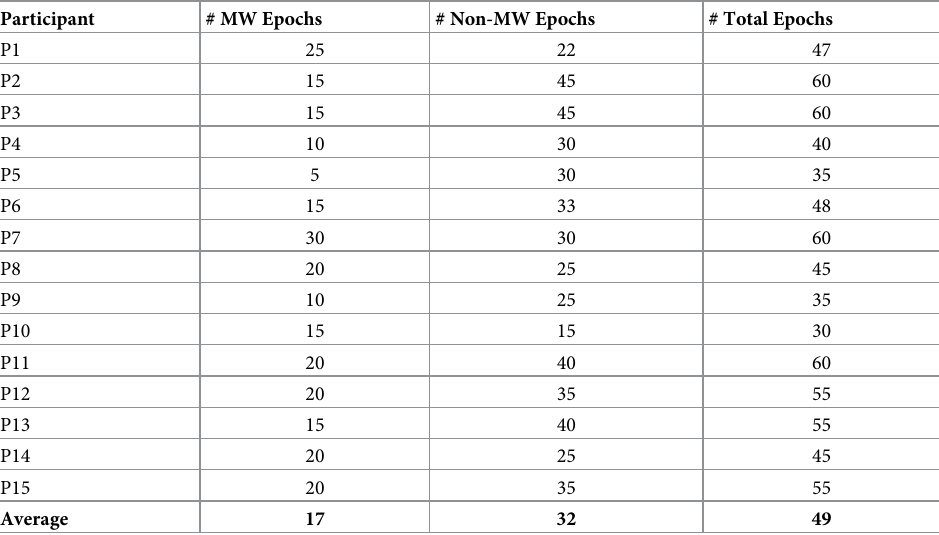
Table 1. The distribution of classes across epochs and total epochs per participant.